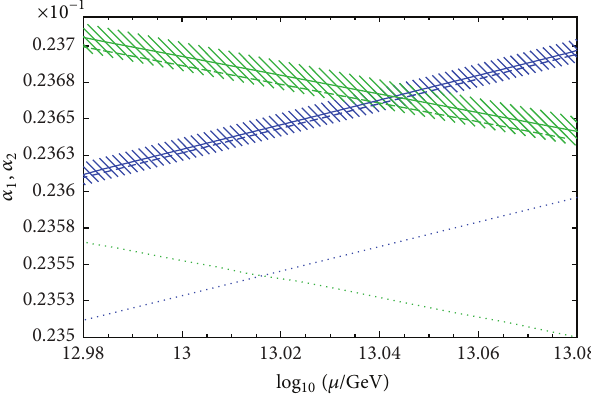
Figure 4: The running of the electroweak gauge couplings in the SM from [49]. The lines with positive slope correspond to 𝛼 1 , the lines with negative slope to 𝛼 2 . The dotted, dashed, and solid lines correspond to one-, two-, and three-loop precision, respectively. The bands around the three-loop curves visualize the experimental